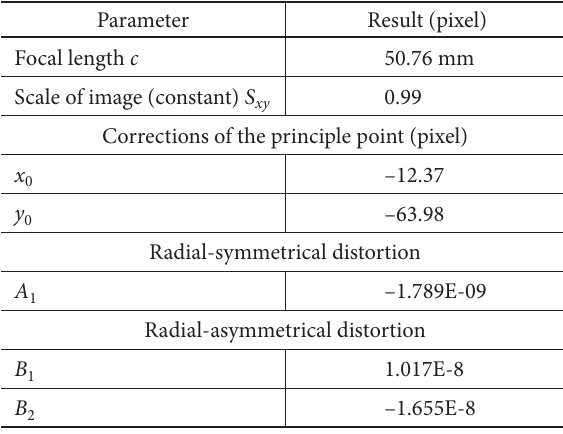
Table 2. Results of calibrating the Canon EOS 1D Mark III